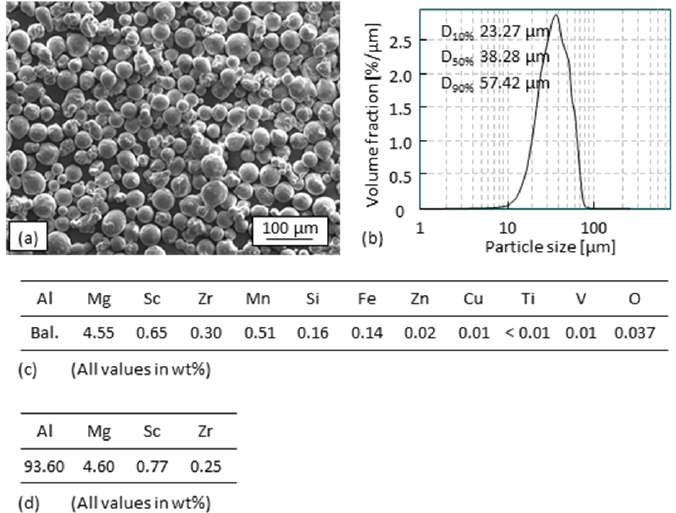
Figure 2. AlMgScZr alloy powder used in this work: ( a ) SEM image, ( b ) powder particle size distribution, ( c ) composition of the powder according to the data sheet, ( d ) content of Al, Mg, Sc, and Zr checked with ICP-OES.